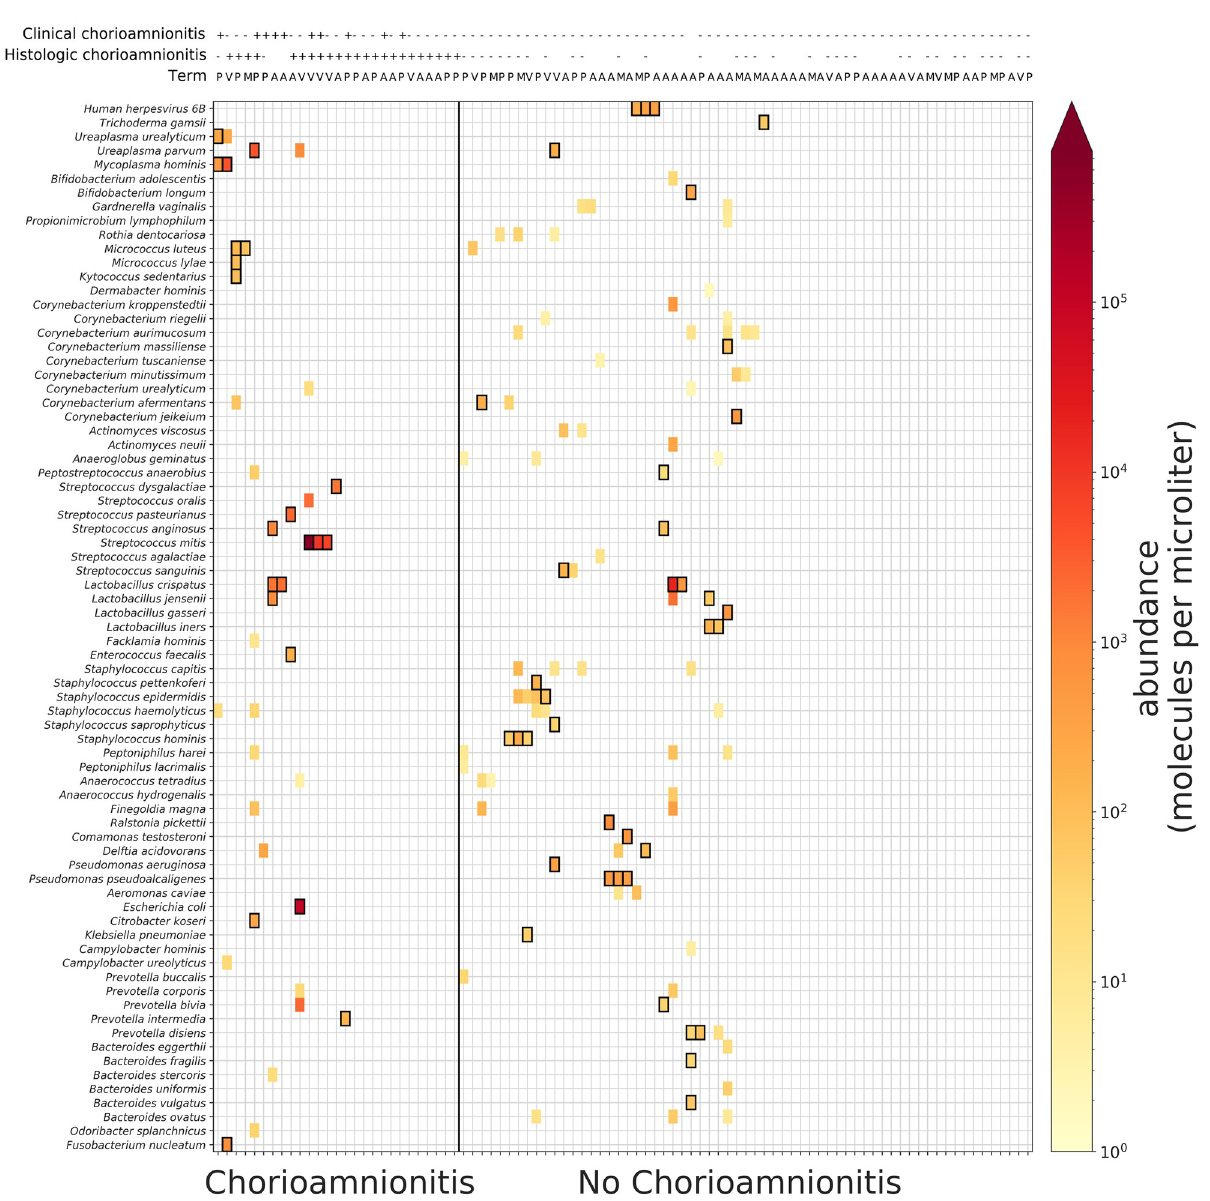
Fig 2. Microbial abundances in umbilical cord plasma detected by next generation sequencing (NGS). Umbilical cord plasma samples that passed quality control and did not appear to be contaminated at the collection site were included in this analysis (n = 90). The microbial abundances of > 1,000 organisms detectable with NGS were compared, and microorganisms were clustered and displayed as a heatmap visualization. Only microorganisms that were present at abundances significantly above the negative control baseline for at least one patient were included in the figure, and then any microorganisms in samples for which the abundances were not at least 2 z-scores above the rest of the samples for the same microorganism were filtered out (see Methods). Black boxes represent calls that were significantly above the baseline determined from negative controls. Presence (+) or absence (-) of clinical and histological chorioamnionitis are shown for each subject above the heatmap.